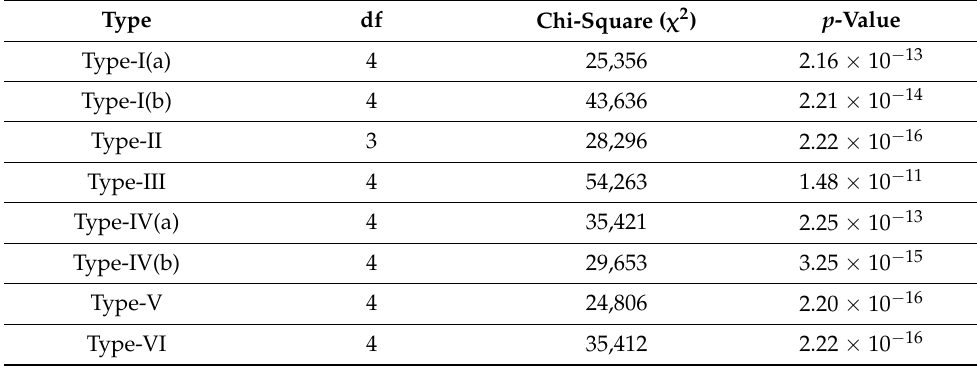
Table 4. Chi-square ( χ 2 ) and p -value of Kruskal–Wallis rank-sum test results.